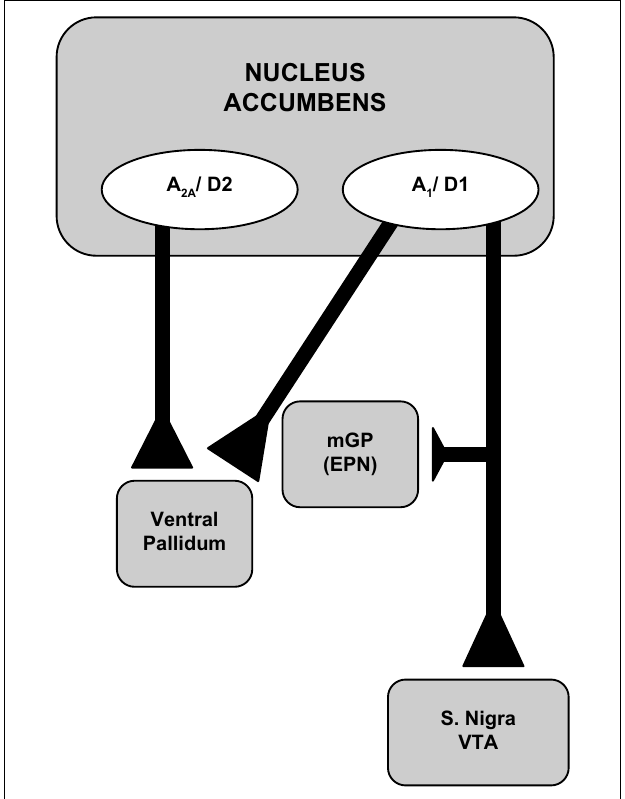
FIGURE 2 | Anatomical diagram depicting the pattern of DA and adenosine receptor localization in nucleus accumbens. See text for details (see also Ferré, 1997; Hillion et al., 2002; Fuxe et al., 2003). mGP, medial globus pallidus; epn, entopeduncular nucleus; s. nigra, substantia nigra; VTA, ventral tegmental